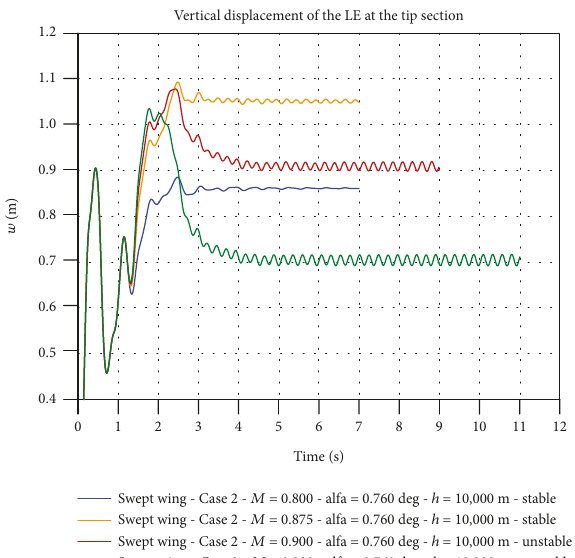
Figure 27: FSI DB — displacement histories at the LE of the swept-wing tip (Case 2 [20]).